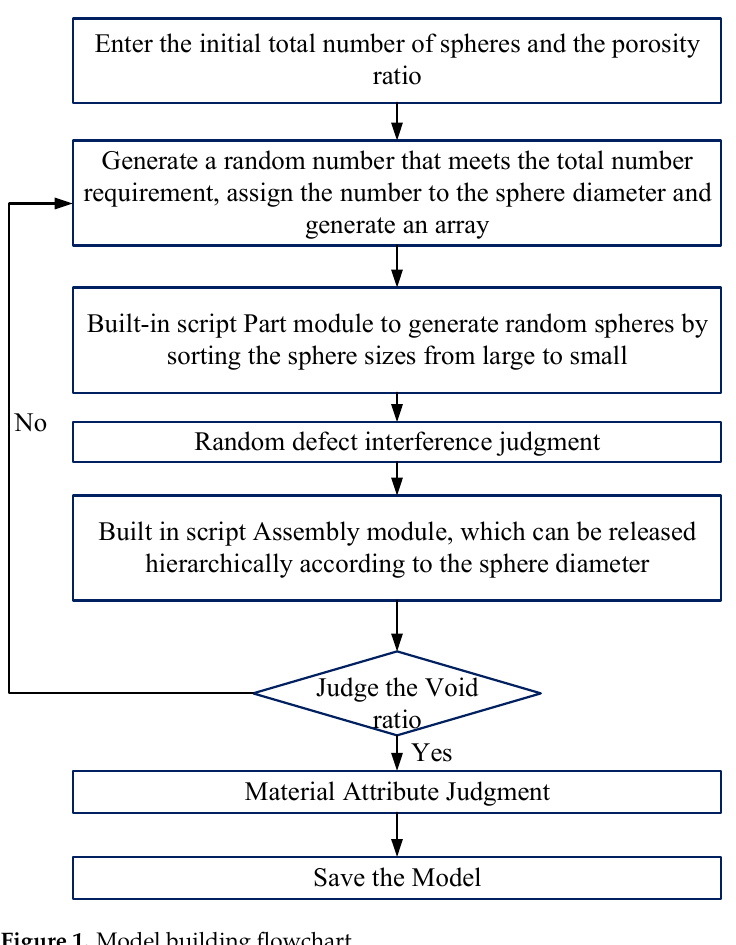
Figure 1. Model building flowchart.